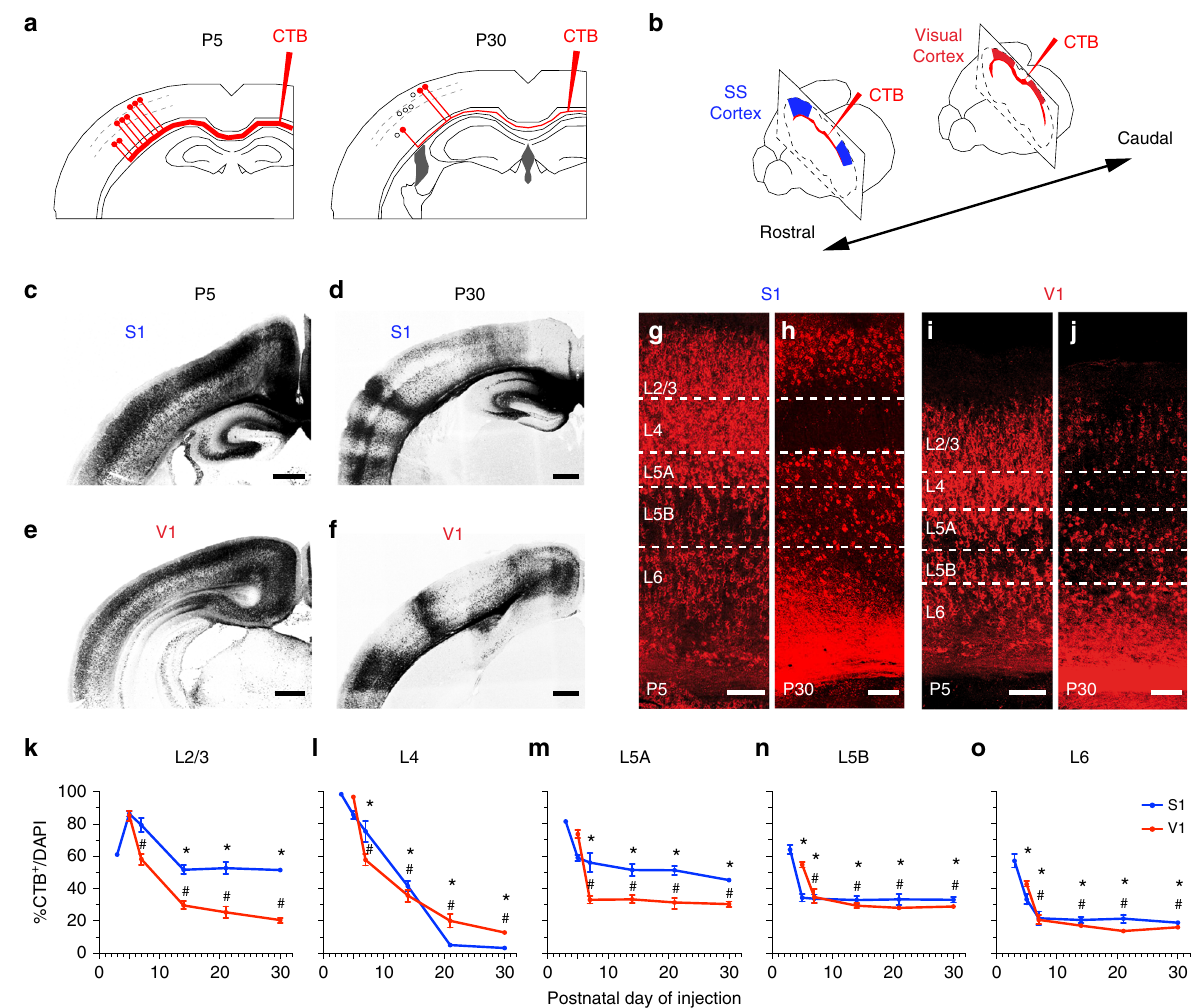
Fig. 1 Retrotracer injections in the CC reveal transient exuberant interhemispheric projections. a , b Cartoons representing neuronal labeling upon injection of CTB in the contralateral CC ( a ) and positions of injections targeting the somatosensory (S) cortex and visual (V) cortex ( b ). c – f Coronal sections of brains injected at P5 ( c , e ) or P30 ( d , f ) in primary sensory cortices (CTB-555 shown in dark). Minor anterograde transport highlights axonal columns